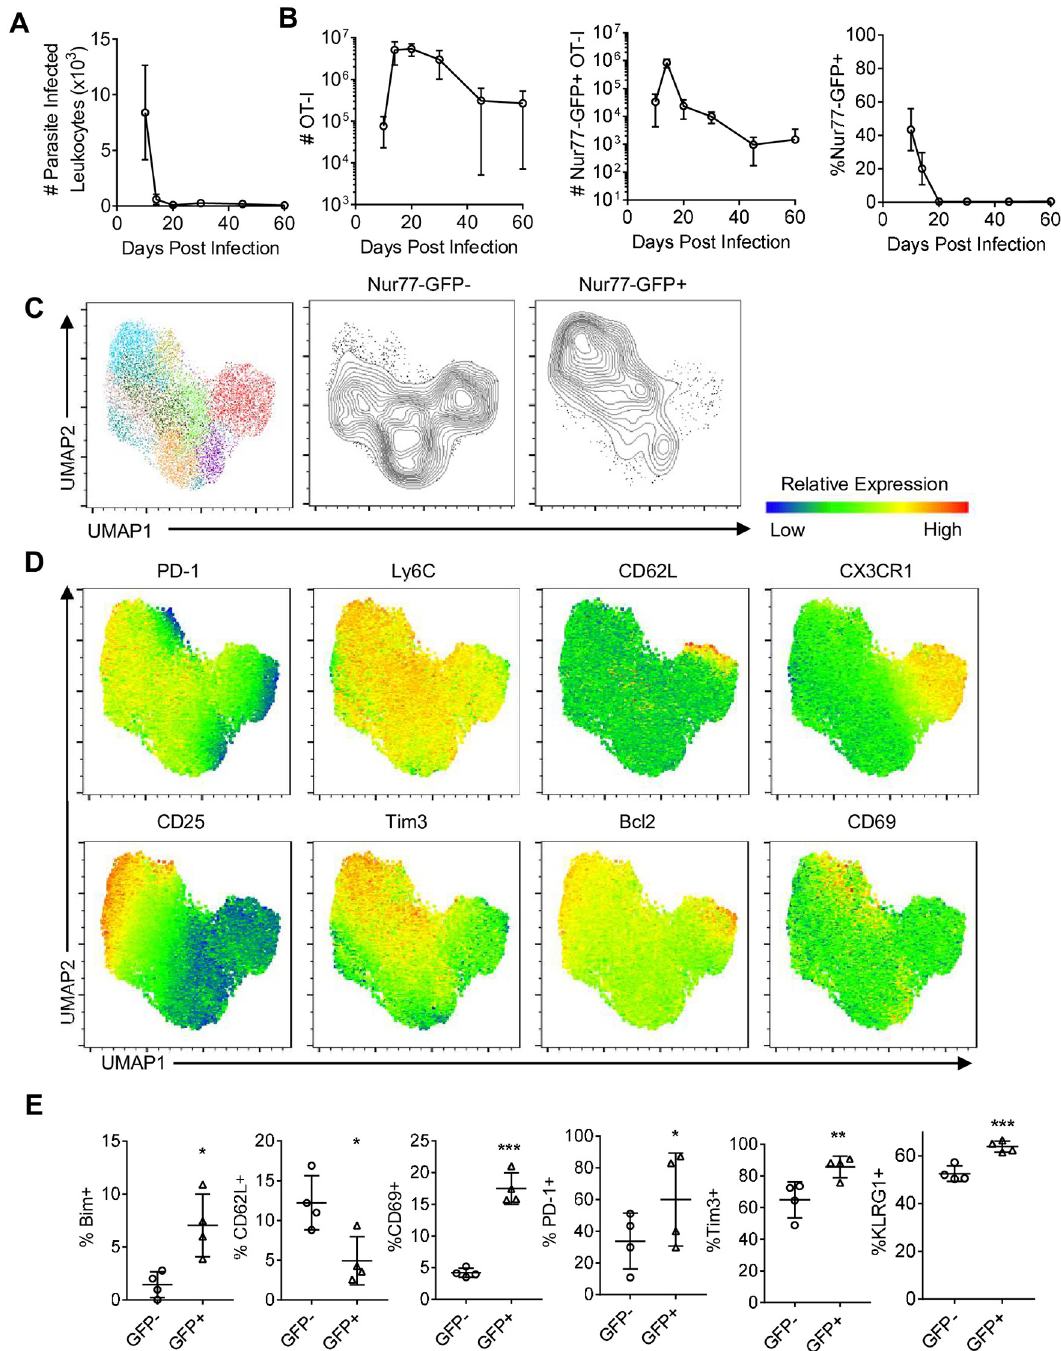
Fig 2. Infection induced kinetics and phenotype of splenic T . gondii specific CD8 + T cells. (A-B) OT-I were transferred i.v. into naive mice and infected with T . gondii -OVA. Mice were sacrificed between 10 and 60 dpi and spleens were analyzed (N = 3–5 mice per time point). (A) Number of parasite infected leukocytes per spleen as measured by flow cytometry. (B) Number of OT-I (left), number of Nur77-GFP + OT-I (center), and frequency of Nur77-GFP + OT-I of total OT-I (right) in the spleen. (C-E) High dimensional flow cytometry with UMAP and Phenograph clustering was performed on splenic OT-I at 10 dpi (N = 4 mice). (C) UMAP segregation of clusters of all OT-I (left), Nur77-GFP + OT-I (center), and Nur77-GFP + OT-I (right). (D) Heatmap of marker expression from UMAP. (E) Frequency of marker positive OT-I within Nur77-GFP - or Nur77-GFP + OT-I fraction. P values based on Paired T-test � p < 0.05, �� p < 0.01, ��� p < 0.001; error bars indicate SD.